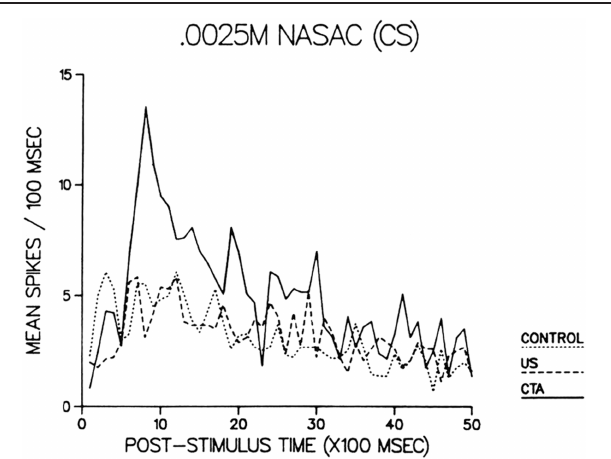
FIGURE 1 | Post-stimulus time histograms of the mean responses among sweet-sensitive neurons in the nucleus of the solitary tract to the conditioned stimulus: 0.0025 M sodium saccharin. Activity is shown for control (dotted line), pseudoconditioned (dashed line), and conditioned (solid line) rats. The enhanced activity during the first three seconds of the evoked response in conditioned animals may represent the increased salience of the sodium saccharin taste and its aversive